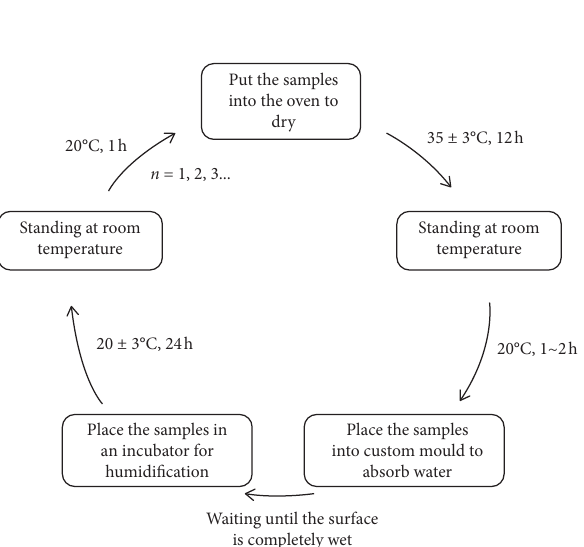
Figure 2: Slaking test mould.